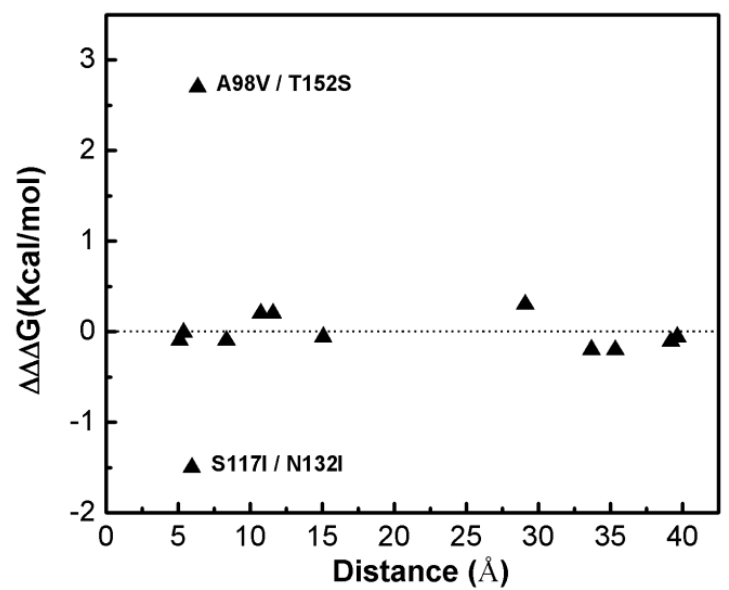
Figure 2. The dependence of the double-site mutation effects on the distances between the two corresponding single sites of the T4 phage lysozyme.